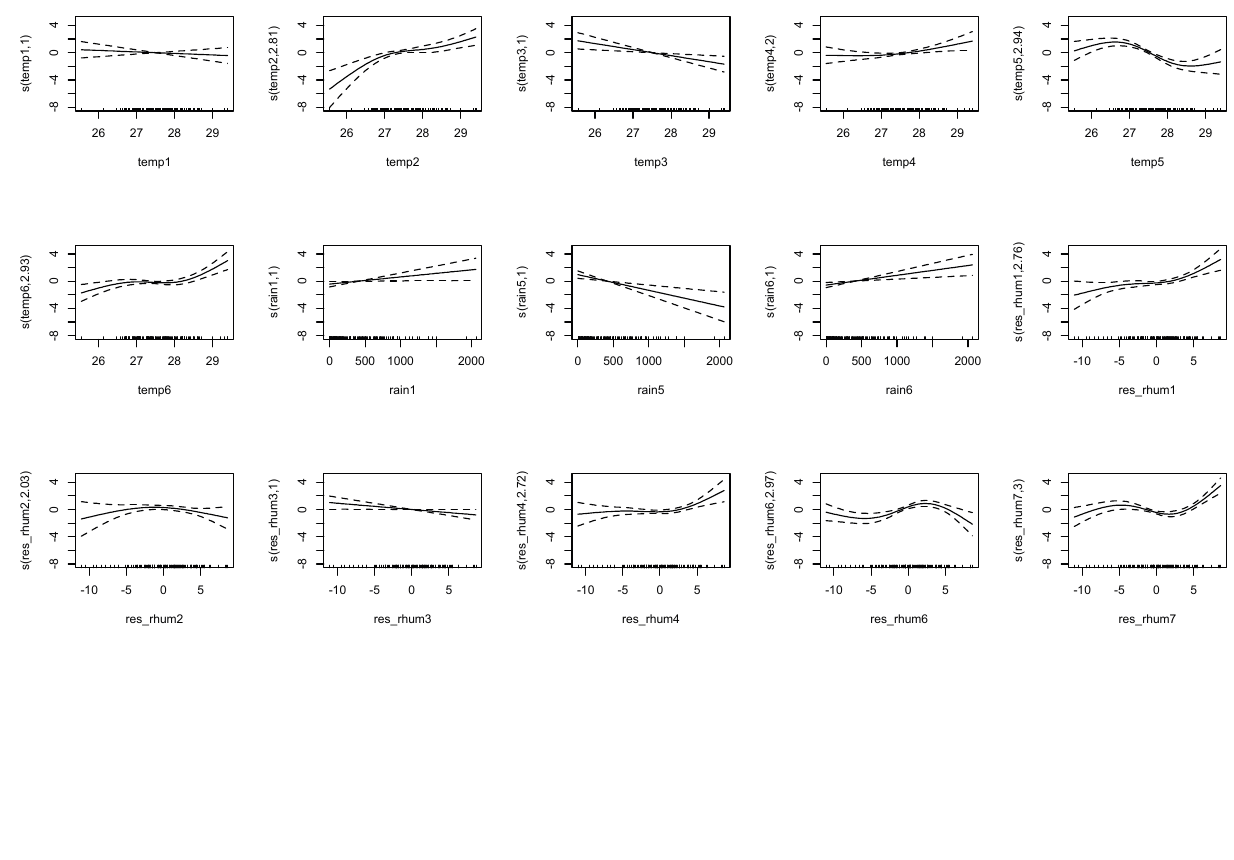
Figure 3. Relative risk of dengue cases as functions of respective climate variables at various lag